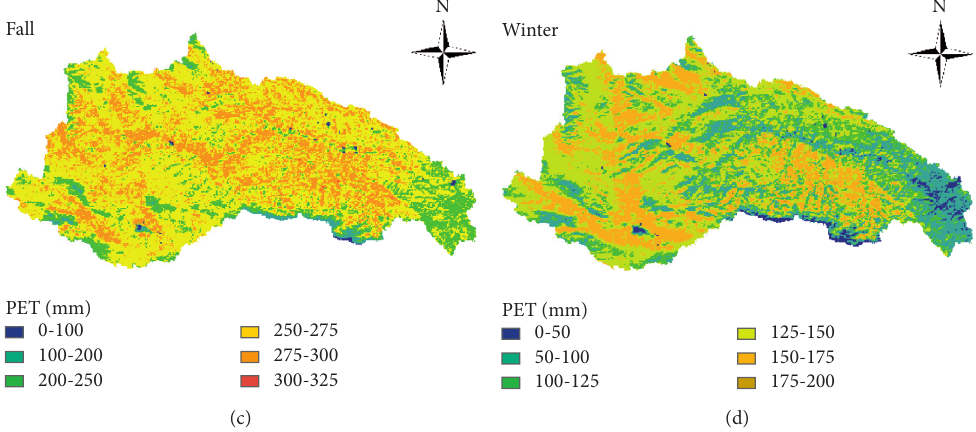
Figure 10: Spatial distributions of seasonal PET during 2001–2018 in the upper Taohe River